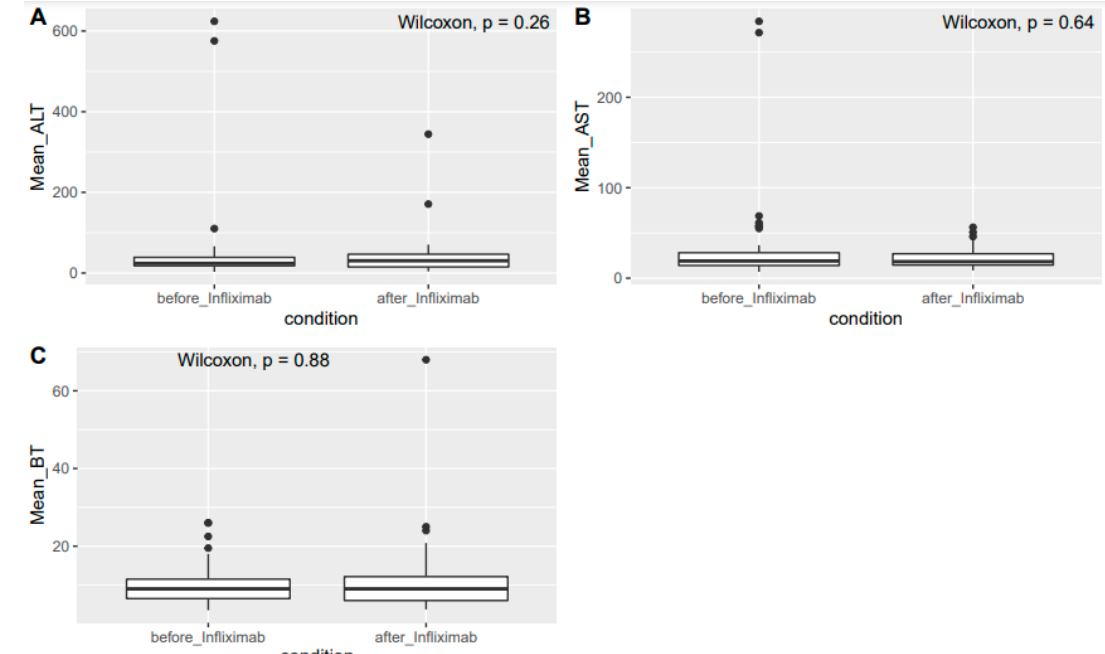
Figure 1. ( A ) Mean values of AST before and after infliximab. ( B ) Mean values of ALT before and after infliximab. ( C ) Mean values of TBILI before and after infliximab.